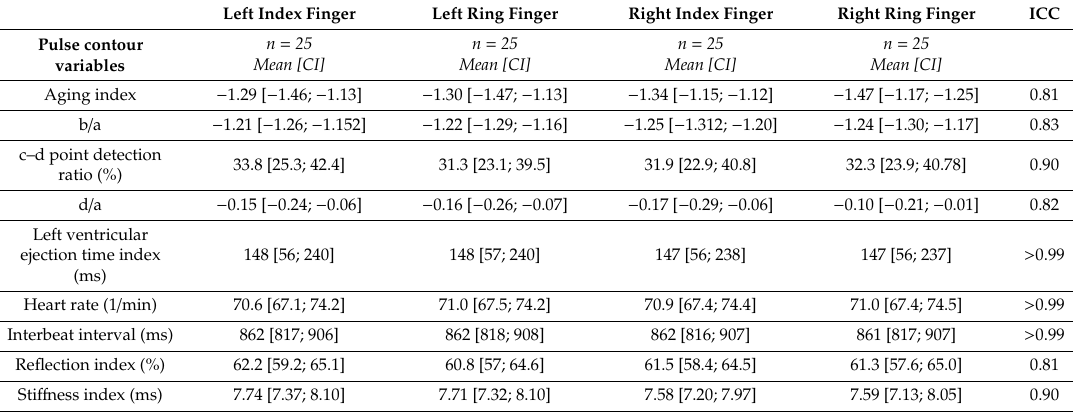
Table 3. Results of measurements performed in parallel on 4 separate fingers on 25 healthy individuals. For each individual, 2 consecutive 4-finger measurements were taken, and the average of the 2 was used for further calculations. The results of the 25 subjects were averaged for each finger separately and are presented in the table with bracketed confidence intervals (CIs). Intraclass coe ffi cients (ICC) were calculated to assess the correlation of results within the same